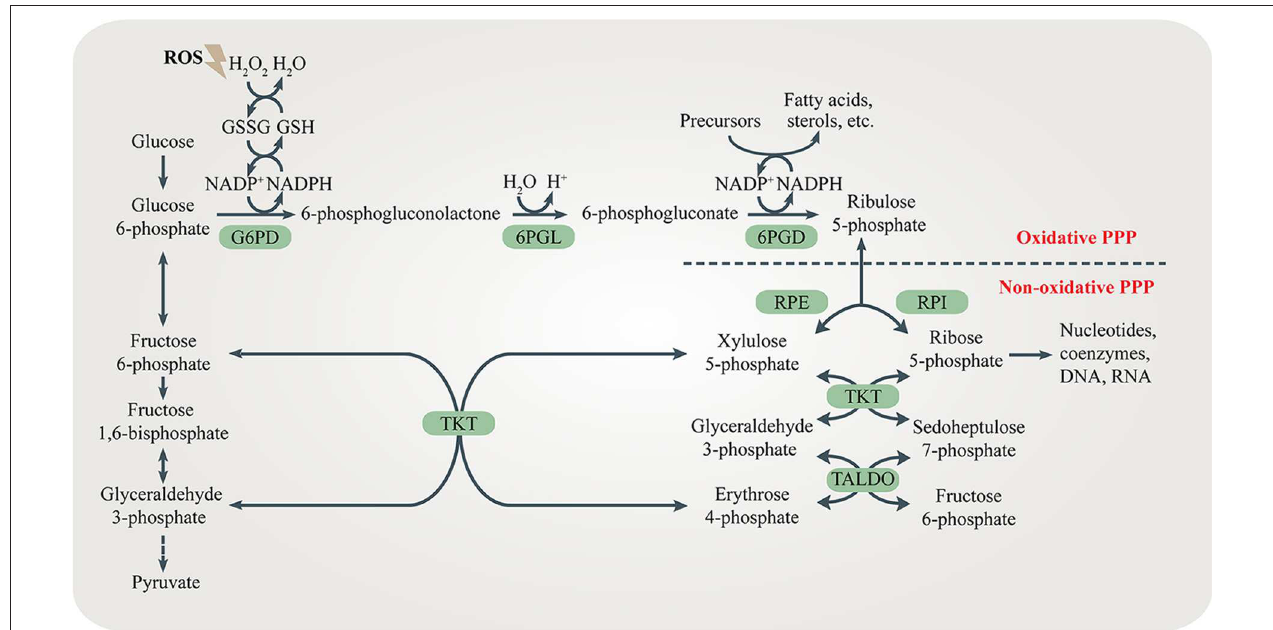
FIGURE 1 | The pentose phosphate pathway (PPP). The PPP branches after the first step of glycolysis and goes back to fructose 6-phosphate and glyceraldehyde 3-phosphate in the glycolytic and gluconeogenic pathway. The PPP produces R5P and NADPH for biosynthesis and redox regulation. Enzymes in the oxidative and non-oxidative PPP are shaded in